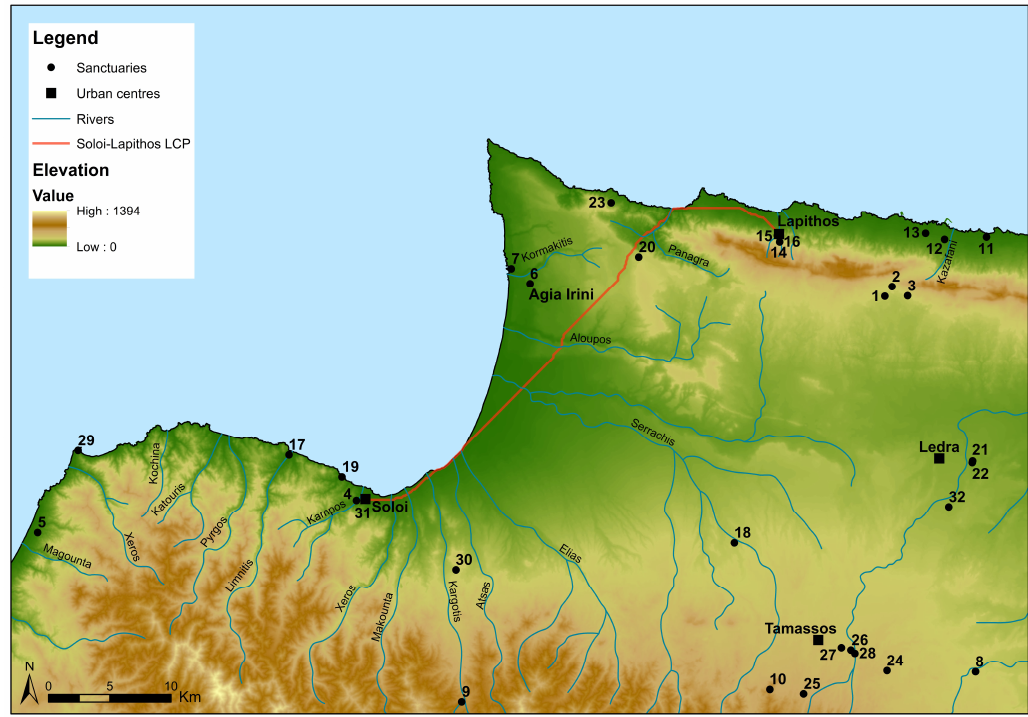
Figure 13. Least Cost Paths Analysis from Soloi to Lapithos; Digital data courtesy of the Geological Survey Department, Cyprus (by Charalambos